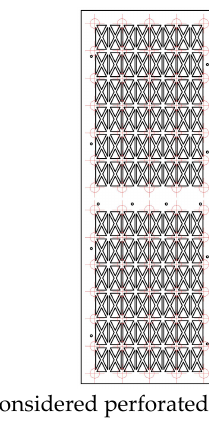
Figure 10. Impact hammer strike points, as implemented in the considered cases.